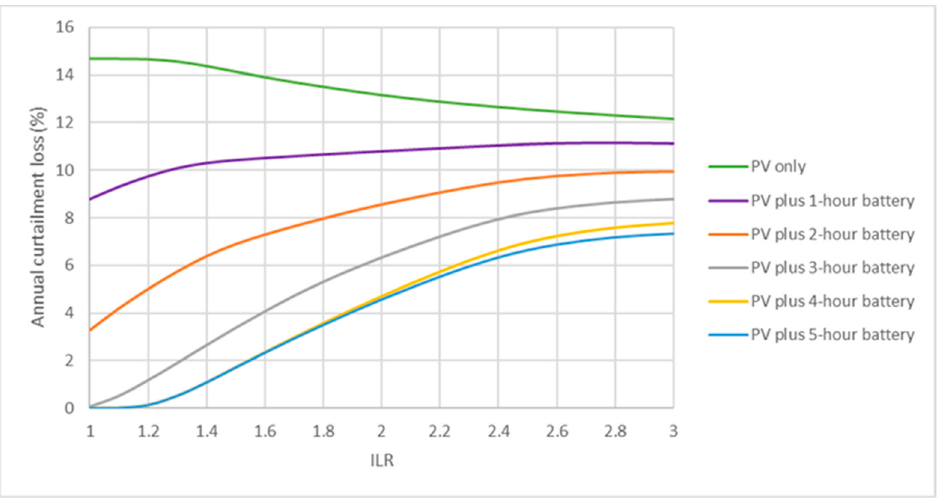
Figure 13. Variation of curtailment rate with ILR for different battery capacities for Scenario IV (fixed tilt).